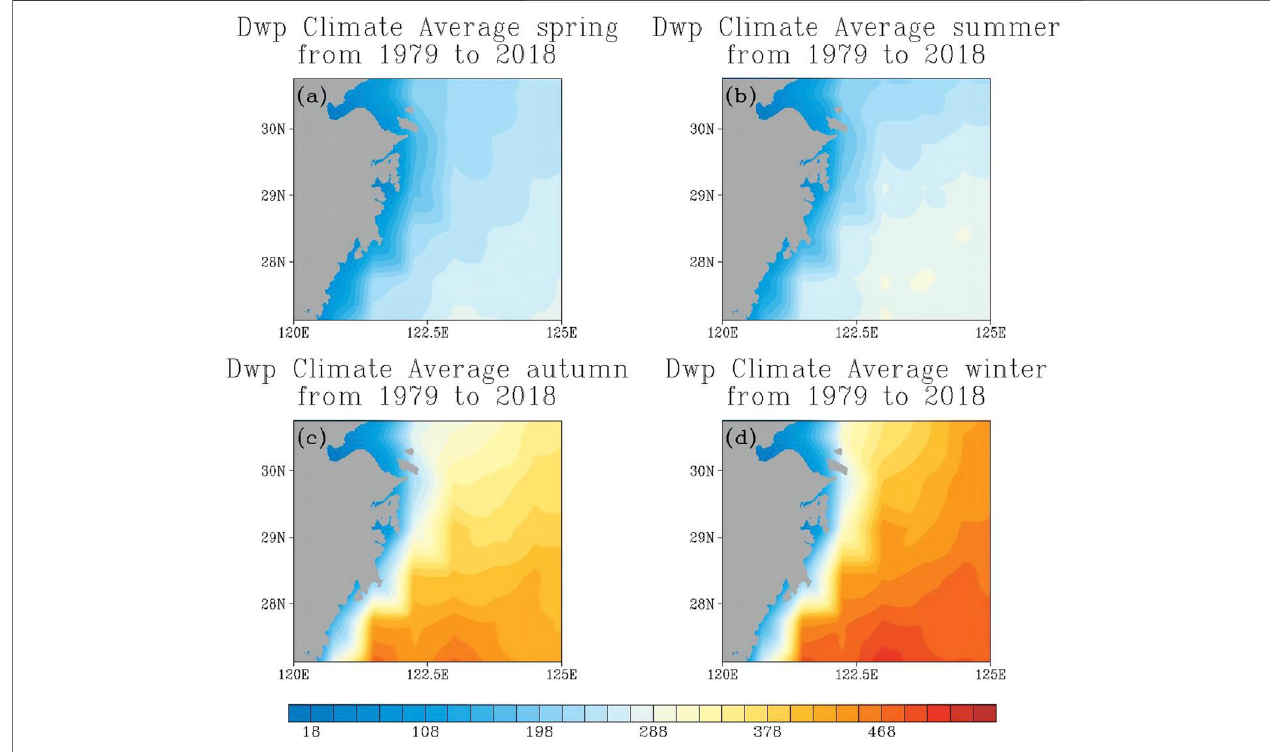
FIGURE5| TheseasonalclimateaverageofZhejiangcoastalwindenergyresource(units:w · m − 2 ):(a)thespringDwp;(b)thesummerDwp;(c)theautumnDwp;(d)thewinterDwp.